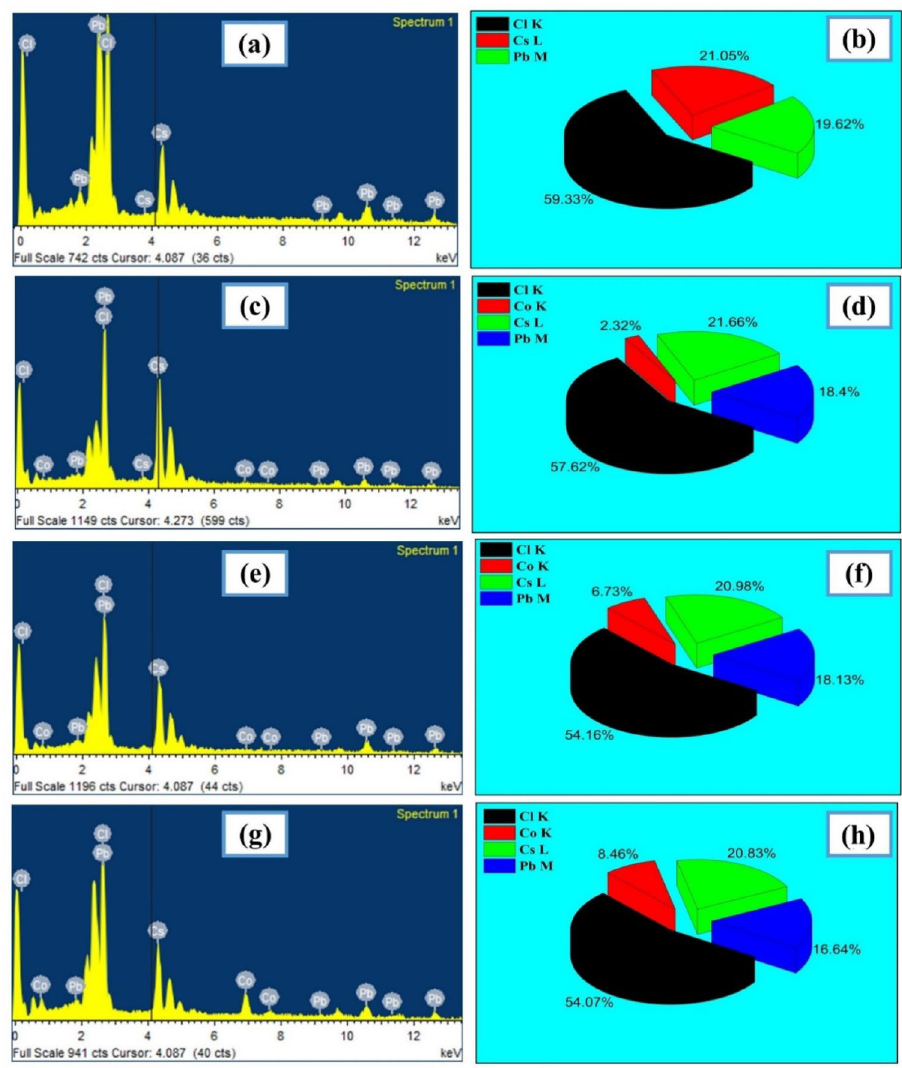
Figure 6. The EDS and Atomic Composition of CsPbCl3 and Co:CsPbCl 3 .